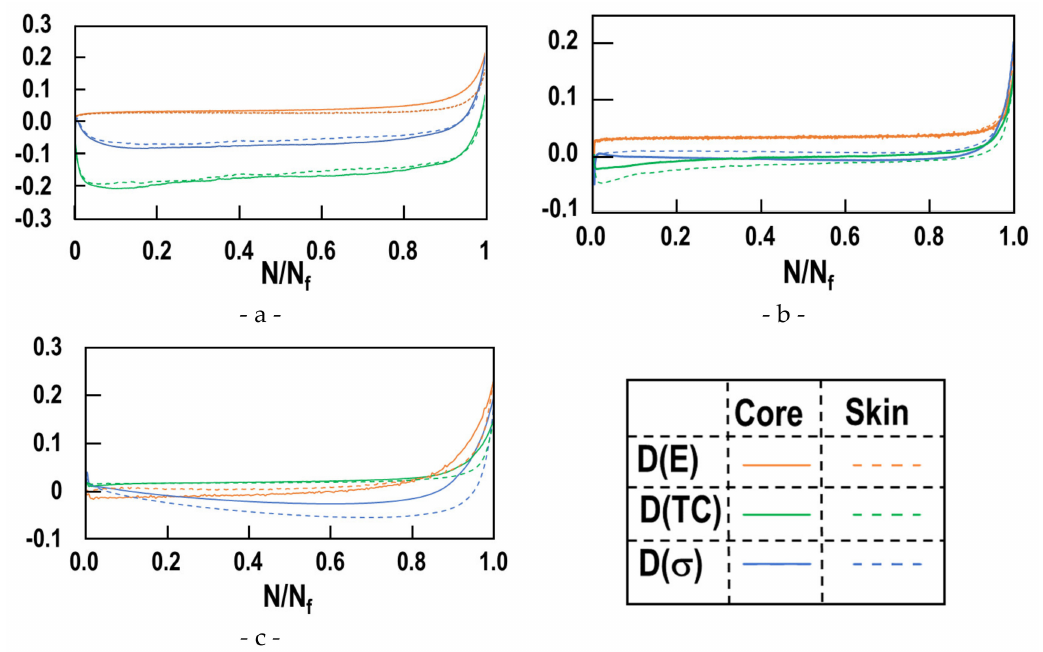
Figure 13. Comparison of three most common damage variables for all considered strain levels ∆ ε P /2: 0.01% ( a ), 0.2% ( b ), and 0.4%( c